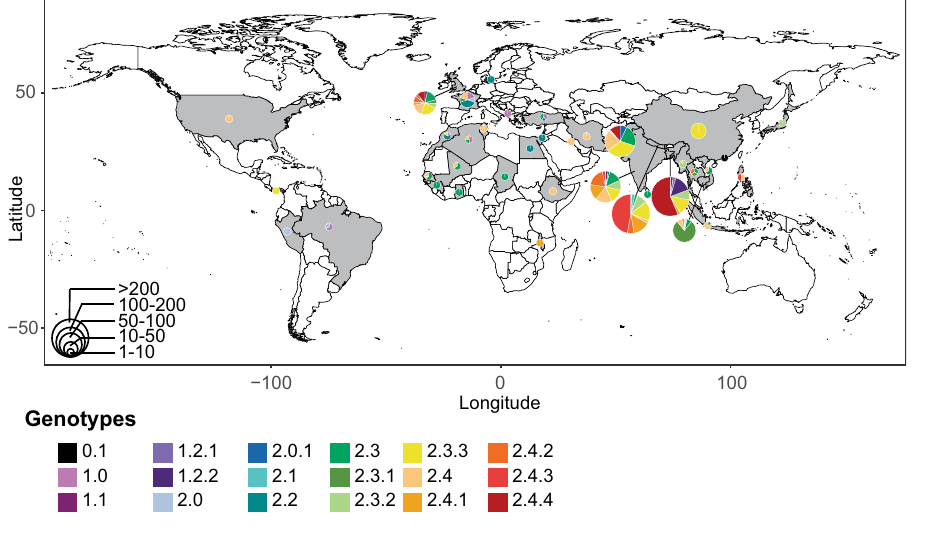
Fig. 3 | Geographical distribution of Salmonella Paratyphi A genotypes. The country of isolation for 1378 sequenced Salmonella Paratyphi A isolates is shown. Thedistributionofgenotypespercountryisshownasscatteredpiecharts.Thesize